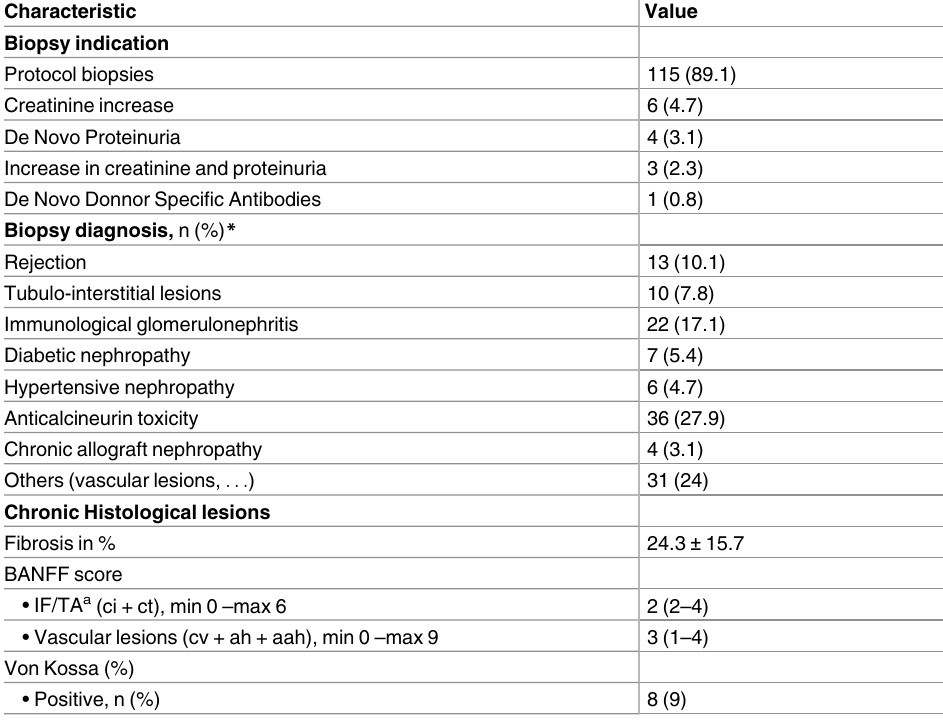
Table 2. Baseline characteristics of the study population (n = 129): biopsy indication, biopsy diagno- sis and chronic histological lesions.